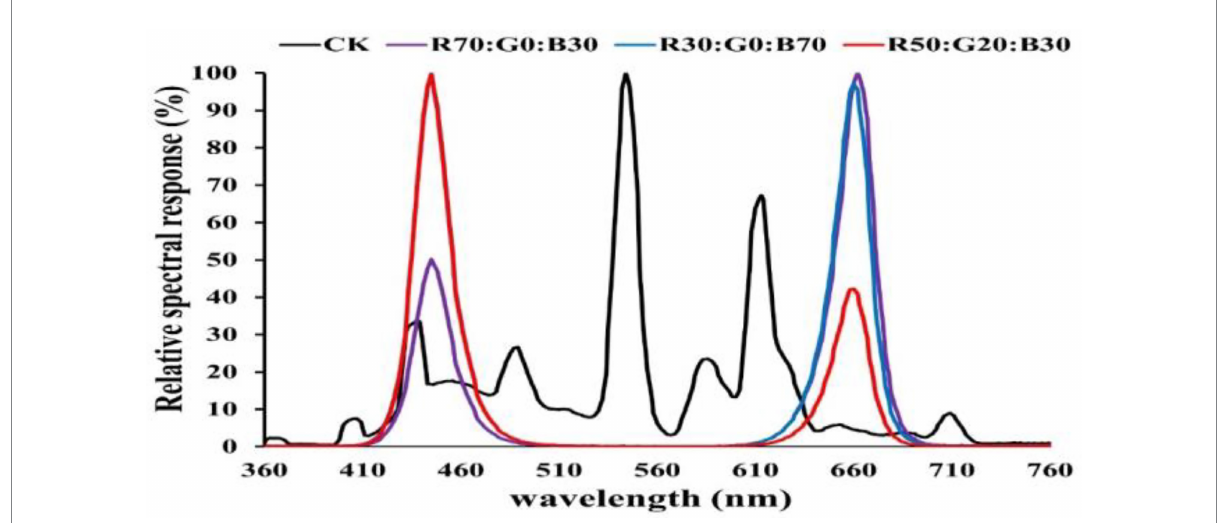
FIGURE 1 In the experiment, the spectrum distribution of the nine LED light modes and the control light.